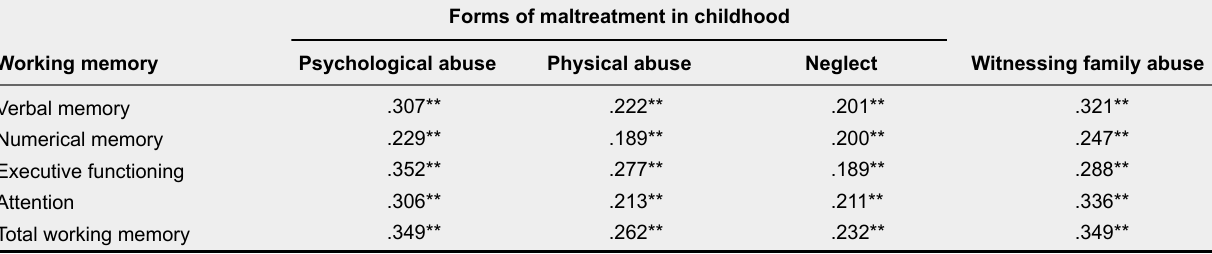
Correlations Between Forms of Maltreatment in Childhood and Difficulties in Working Memory Capacity Forms of maltreatment in childhood Working memory Witnessing family abusePsychological abuse Physical abuse Neglect Verbal memory .307** .222** .201** .321** Numerical memory .229** .189** .200** .247** Executive functioning .352** .277** Attention